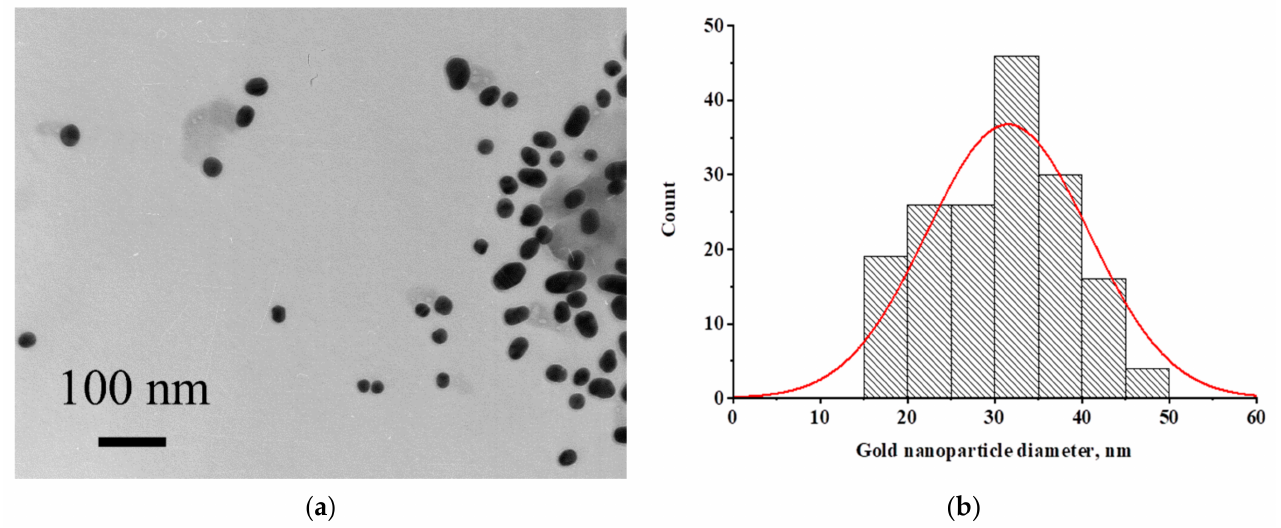
Figure 2. ( a ) Micrograph of the conjugate of gold nanoparticles with staphylococcal protein A. ( b ) Histogram of particle size